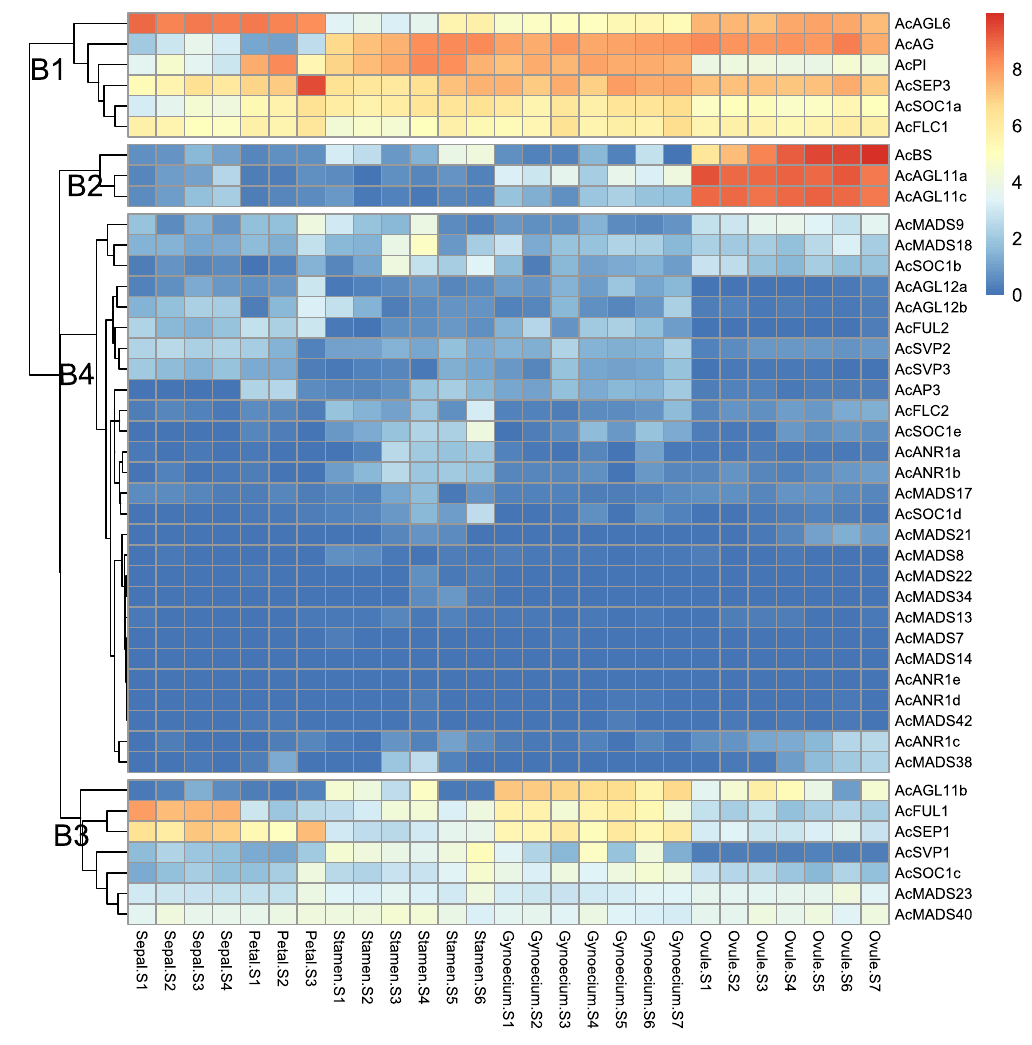
Figure 7. Expression heat map of MADS-box genes in five representative floral organs (sepals, petals, stamens, pistils, and ovules) at different developmental stages of pineapple. The different developmental stage samples comprised four sepal stages (S1–S4), three petal stages (S1–S3), five stamen stages (S1–S5), and seven stages of pistils (S1–S7) and ovules (S1–S7). The expression value was quantified as fragments per kilobase per million reads (FPKM), and relative gene expression data were gene-wise normalized. AcMADS43 was not detected at any developmental stage. Four major expression groups were marked as B1, B2, B3, and B4. The color scale bar is at the top-right corner; blue, white, and red indicate low, medium, and high expression levels,